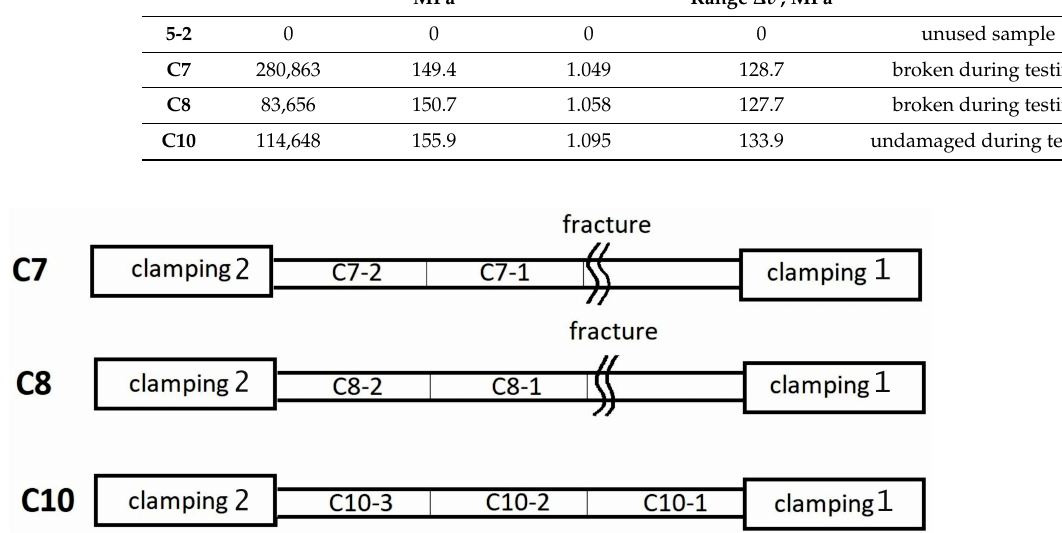
Figure 1. A diagram of the wires (Table 1) from which samples were cut out for XRD and acoustic measurements (Supplementary Materials Table S1) after cyclic tests.